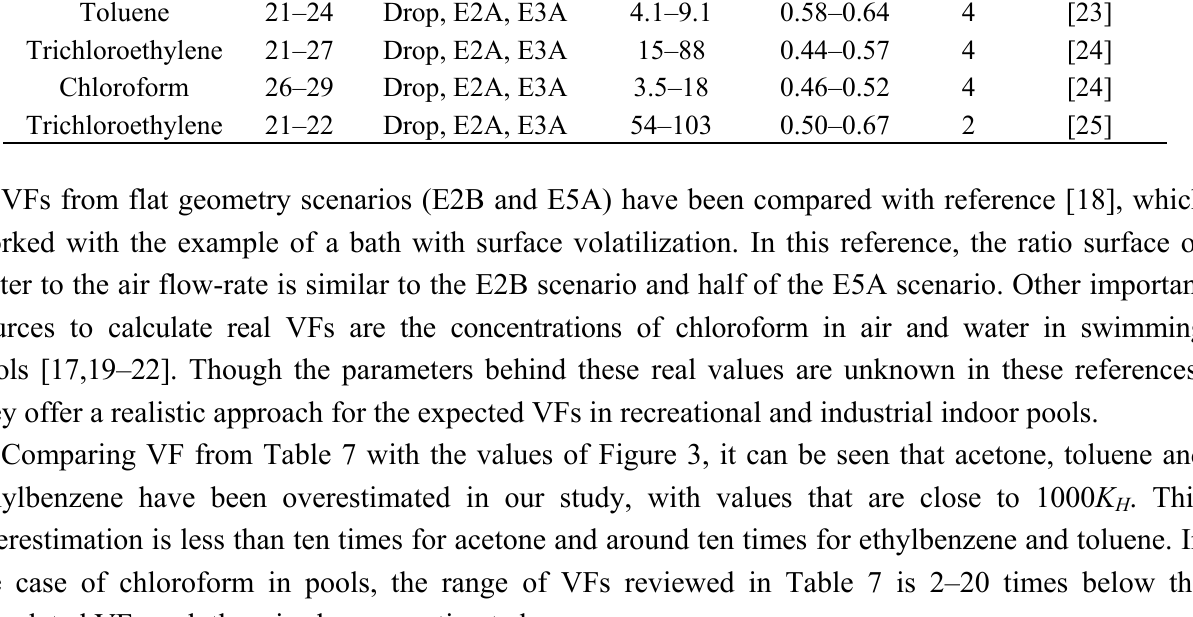
Table 7. Experimental indoor VFs and f